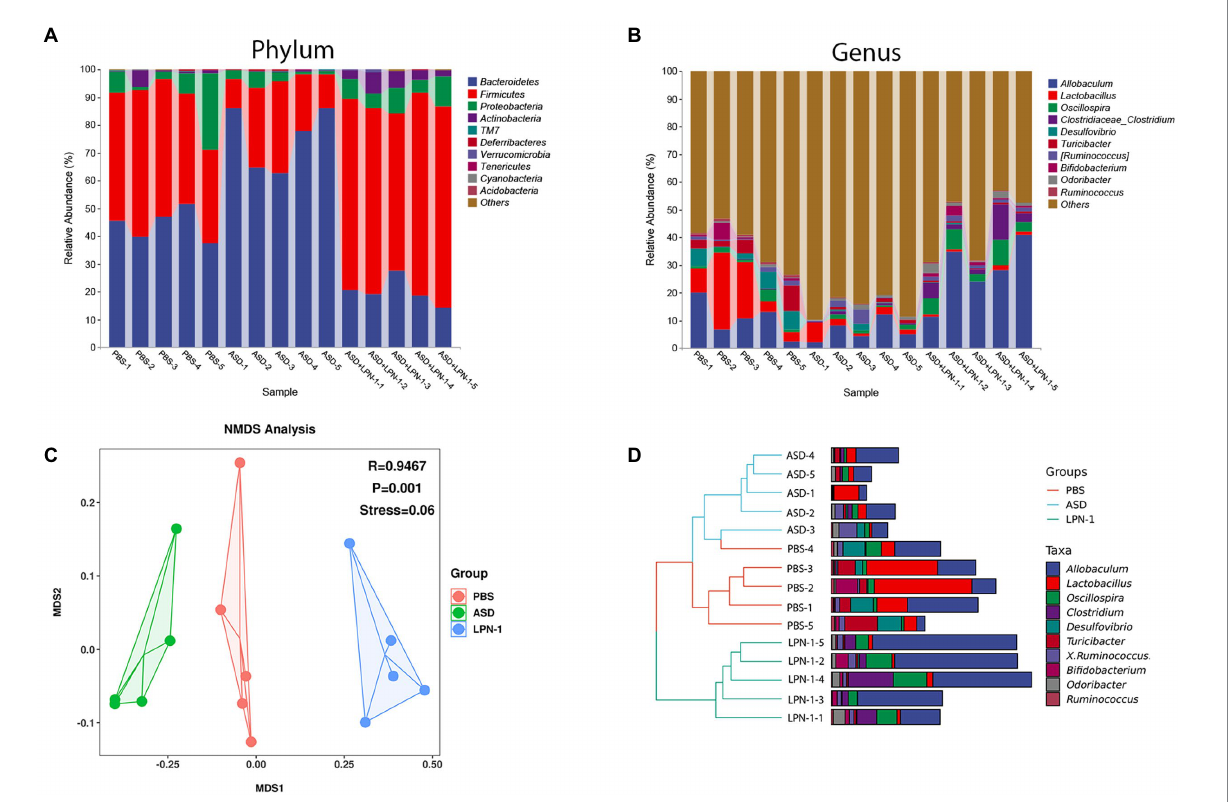
FIGURE 6 Histogram of species distribution at the phylum (A) and genus (B) levels revealed by 16S rRNA sequencing. NMDS analysis based on weighted_unifrac_ distance among phosphate-buffered saline (PBS), autism spectrum disorder (ASD), and ASD + LPN-1 groups (C) . Hierarchical clustering analysis (D)